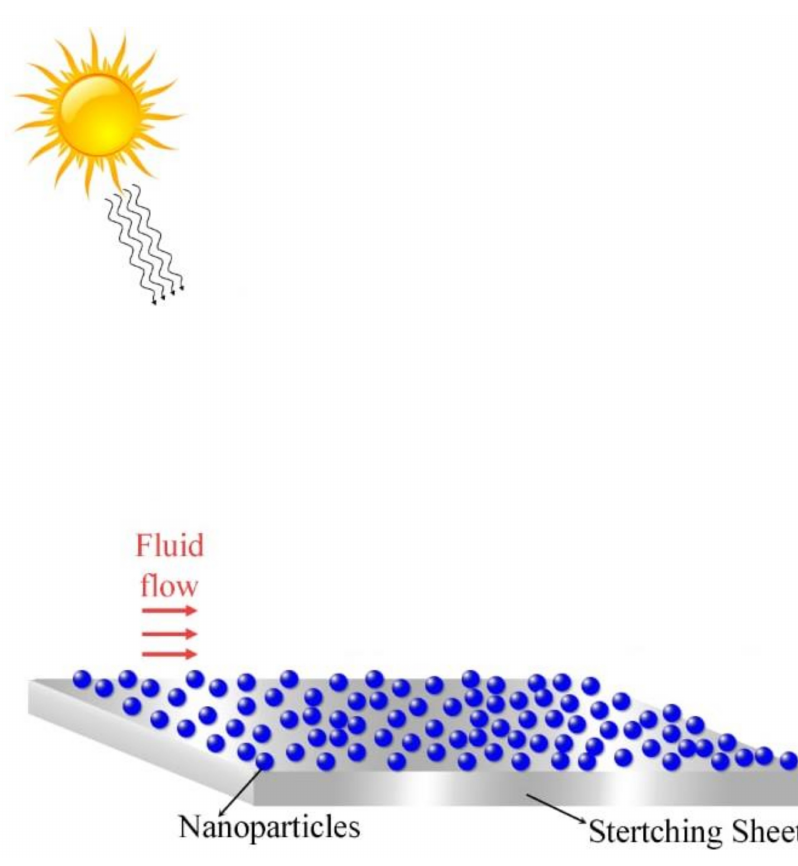
Figure 1. Schematic of the flow